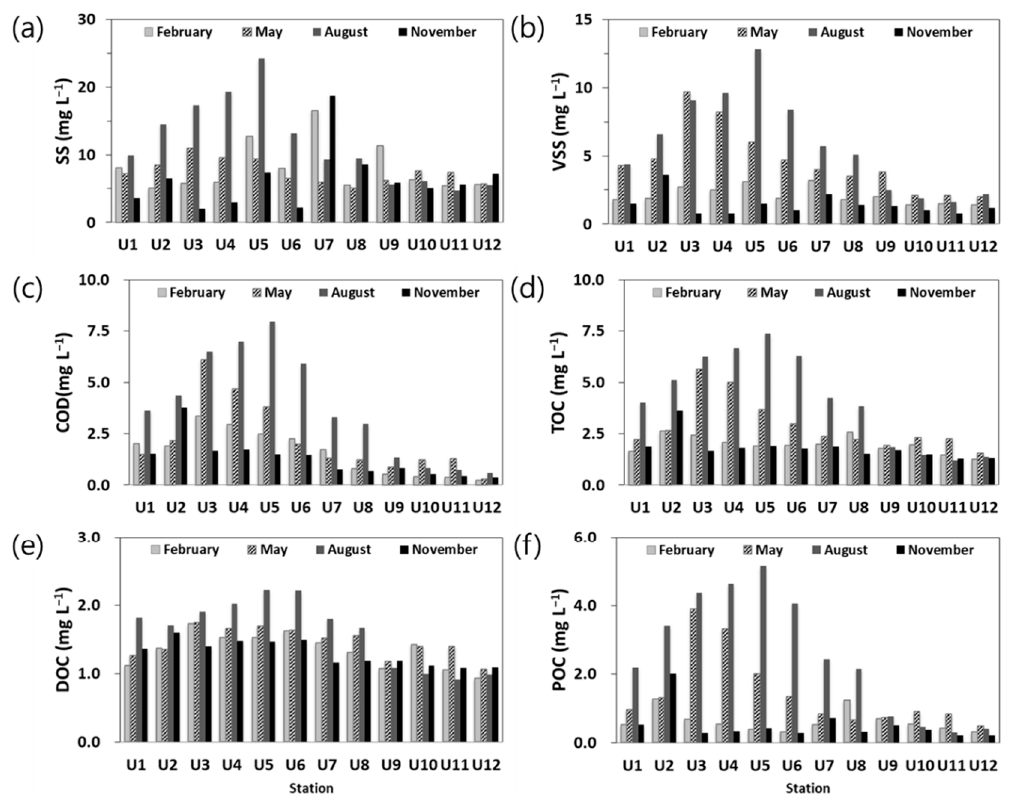
Figure 4. Spatiotemporal distributions of organic matter in the Taehwa River estuary in Korea. ( a ) Suspended solids (SS), ( b ) volatile suspended solids (VSS), ( c ) chemical oxygen demand (COD), ( d ) total organic carbon (TOC), ( e ) dissolved organic carbon (DOC), and ( f ) particulate organic carbon (POC).